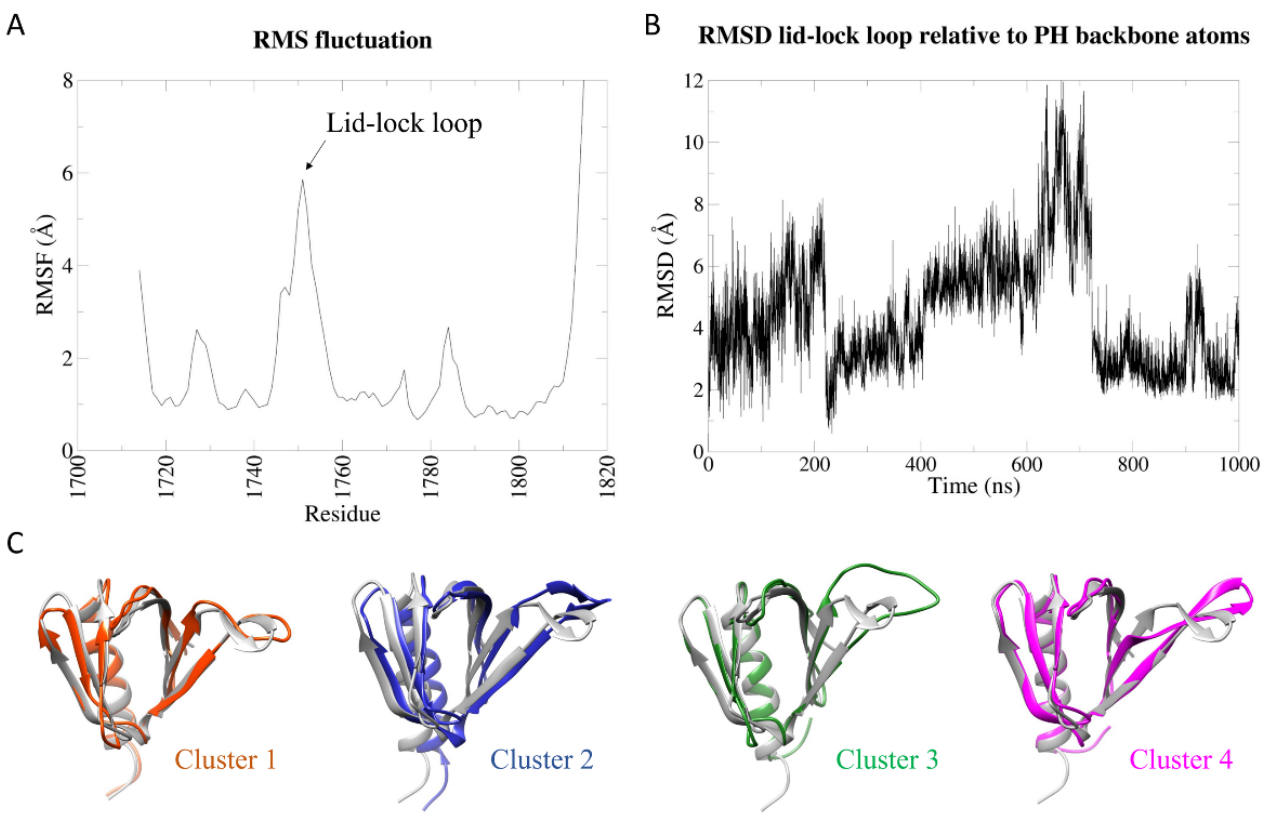
Figure 2. Analysis of the K1750Δ isolated PH domain MD simulation. ( A ) Root-mean-square fluctuation (RMSF) of backbone atoms of the PH domain. ( B ) Root-mean-square deviation (RMSD) of the backbone atoms of the lid-lock loop after superposition of the entire PH domain backbone atoms. ( C ) Centroids of the first four clusters (colored) were aligned against the crystal structure (grey). Cluster 1 and cluster 4 resemble state 1 and state 2 of the wt and the left-right swing due to conformational change in the beta strand before the loop. Cluster 2 and cluster 3 show the “up motion” of the loop, with the flip in the bending orientation (cluster 3) that could not be observed in the wt.